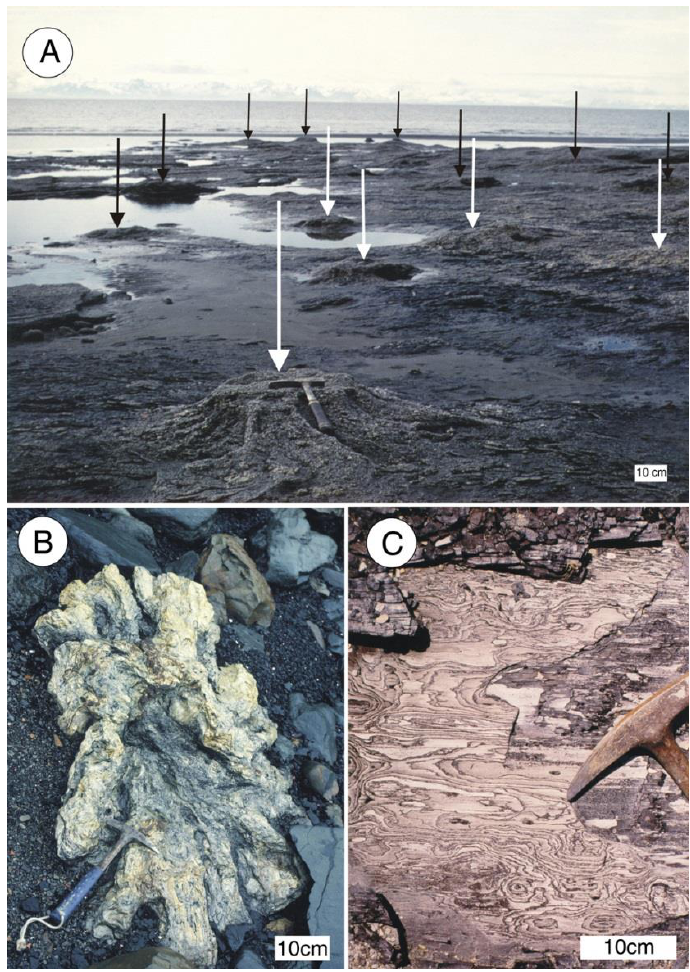
Figure 12. Late Miocene siderite mineralized wood Kenai Group near Homer, southern Alaska, USA. ( A ) Siderite mineralized stumps weathering from coal bed in intertidal zone north of Diamond Creek, Late Miocene Beluga Formation. Arrows mark individual stumps; ( B ) Siderite stump northwest of Michael Creek; ( C ) Close-up view of siderite-mineralized wood. Photos courtesy of Linda Reinike-Smith, used with permission.